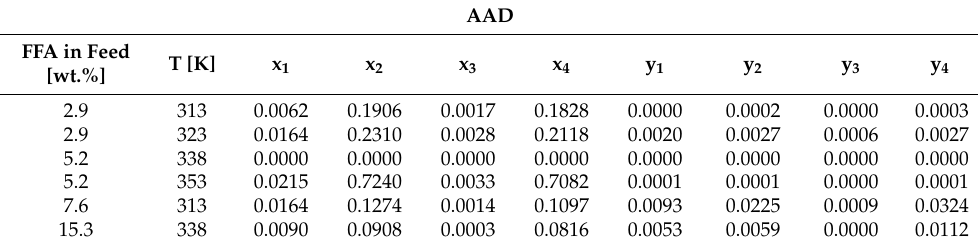
Table 15. The average absolute deviation (AAD) between the predicted and experimental high- pressure phase equilibrium data for the model systems oleic acid(1)-squalene(3)-triolein(2)-CO 2 (4). AAD FFA in Feed [wt.%]